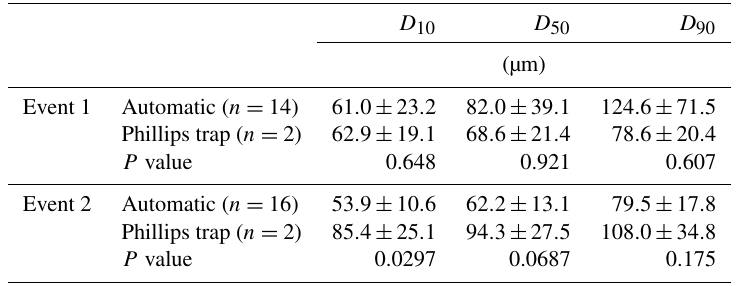
Table 1. Comparison of the particle size, the 10th ( D 10 ), 50th ( D 50 ) and 90th ( D 90 ) percentiles, between the Phillips sampler and the automatic sampler. Weighted averages and standard deviations are given. P values were derived from weighted t tests or Mann–Whitney U tests.